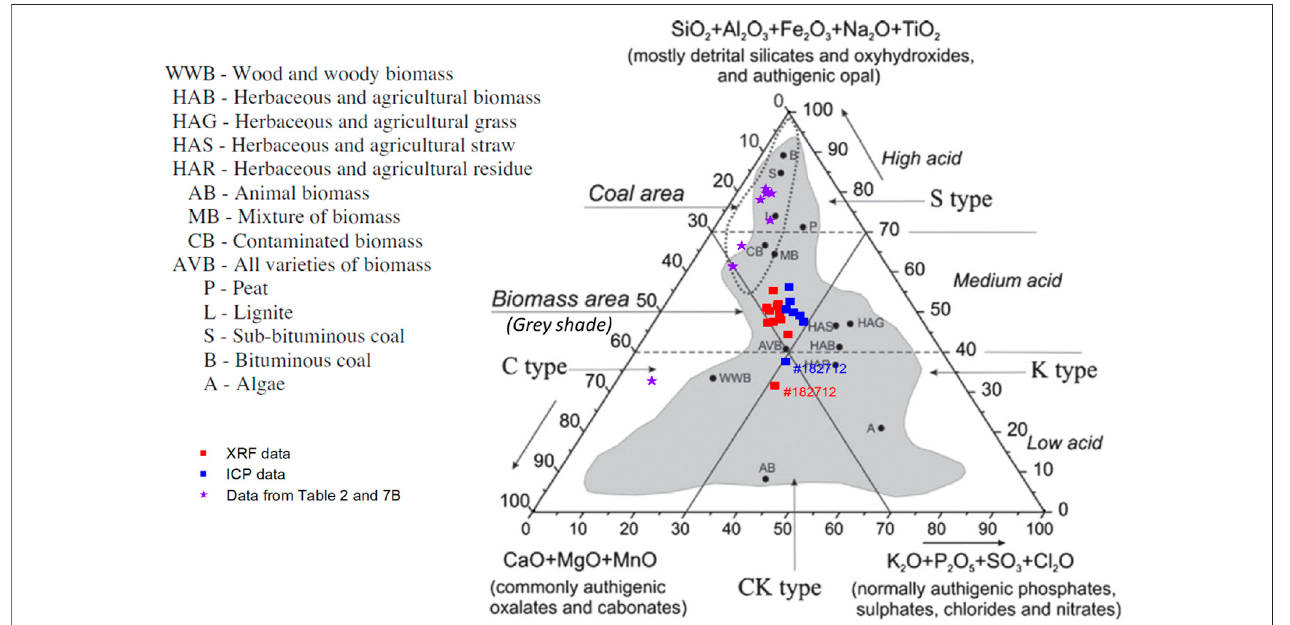
FIGURE 8 | Position areas of CCDWDF samples and referenced solid wastes in the chemical classi fi cation system of inorganic matter in biomass based on (Vassilev et al., 2012). Reprinted from Fuel , 94, Vassilev, S. V., D. Baxter, L. K. Andersen, C. G. Vassileva, and T. J. Morgan. An overview of the organic and inorganic phase composition of biomass. pp 1-33, Copyright 2012, with permission from Elsevier.